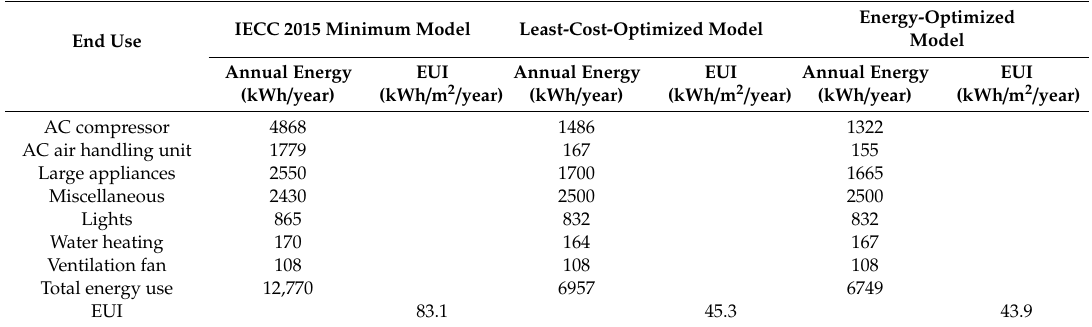
Table 8. Annual energy use (kWh / year) disaggregated by the end use and energy use intensity (kWh / m 2 / year based on the living area) results for the IECC 2015 minimum model, least-cost-optimized model, and energy-optimized model.